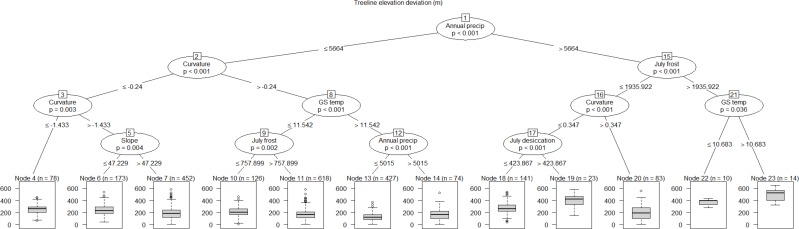
Conditional inference tree explaining treeline elevation deviation across 28 study areas using the 12 most important explanatory factors determined from the random forest analysis.The tree shows pathways of how the response data were recursively partitioned based on explanatory variables. The observations associated with each terminal node are the result of these partitionings. For example, Node 4 comprises treeline locations with a median treeline elevation deviation of 250-m, characterised by an annual precipitation <5,664-mm and slope curvatures less than −0.24. P-values at each node are from a Monte Carlo randomisation test; in order for a split to occur p must be less than 0.05.